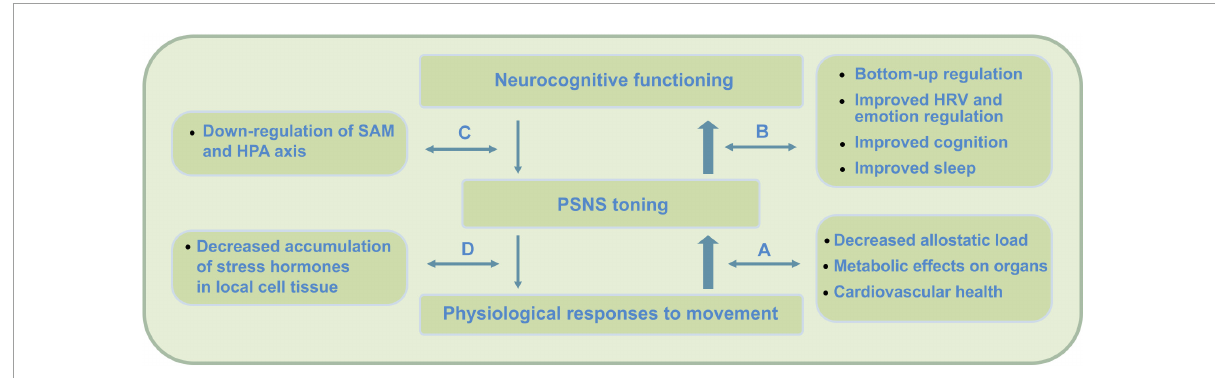
FIGURE2 PE physiological and bottom-up short-term impact on neurocognition. Direct effects of PE include improved neurocognitive functioning due to improved parasympathetic nervous system (PSNS) or vagal tone, changes in physiology, as well as postponed neurorestorative effects through improved quality of sleep. In contrast to mindfulness, research indicates these changes to be strongly moderated by psychophysiological factors. By not exceeding the intensity threshold (around 65% VO 2 max) during PE, which causes accumulation of stress hormones (e.g., Hill et al., 2008), this impact is expected to complement mindfulness practice at an early stage. PE has been found to cause direct physiological changes that support key-mechanisms in meditation practice and MA development. Firstly, PE causes temporal cognitive improvements that can contribute to cognitive processes involved in meditation. Secondly, by causing temporal post-exercise PSNS reactivation and SNS withdrawal, stress buffering potential can be improved. By direct increase of PSNS or vagal tone, during subsequent meditation, self- and emotion regulation processes can be promoted. These psychophysiological and bottom-up regulation effects occur though (A) physiological processes that promote parasympathetic health, (B) increased bottom-up regulation effects through increased neurovisceral feedback, interoception and cognition, (C) improved top-down regulation, and (D) reduction of stress hormones on a cellular level – offering potential for increased feedback sensitivity during stress and somatic awareness.